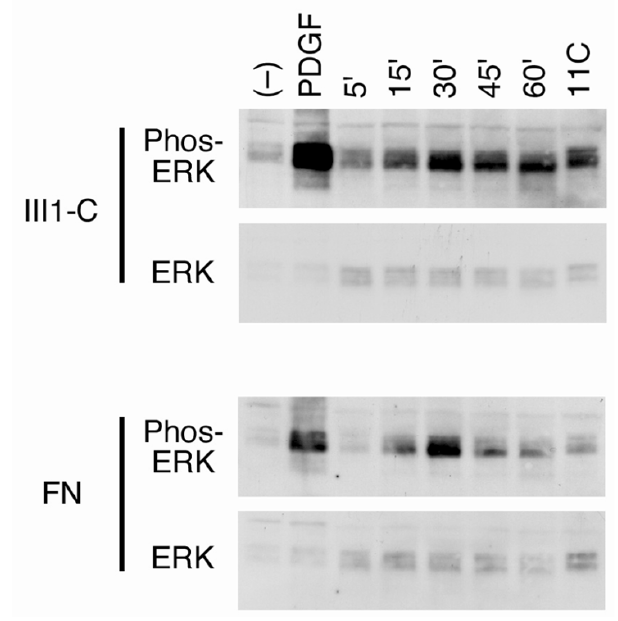
Figure 5 Activation of ERK by cell adhesion to III1-C. RASMCs were collected into DMEM + 0.5% BSA and either kept in suspension in the absence (-) or presence of 2 ng/ml PDGF (PDGF), or were seeded onto dishes precoated with either 20 µ g/ml FN (FN), 25 µ M III1-C (C), or 25 µ M III 11-C (11C). Note that the only cells that received growth factor are the cells in the PDGF lane, which received the growth factor 10 min before lysis. After 5, 15, 30, 45 or 60 min at 37 ° C the cells were lysed in sample buffer and analyzed by inununoblotting with anti-phospho-p44/42 MAPK antibodies (Phos-ERK panel). The blot was then stripped and reprobed with anti-ERK antibodies (ERK panel) to analyze protein loading. This experiment was done more than 3 times with similar results each time. sulfate, and dermatan sulfate all contain iduronic acid residues whereas chondroitin sulfate and hyaluronic acid do not. The results presented above indicate that a heparan sulfate proteoglycan (HSPG) or dermatan sul- fate proteoglycan on the surface of RASMCs may serve as a receptor for III1-C.